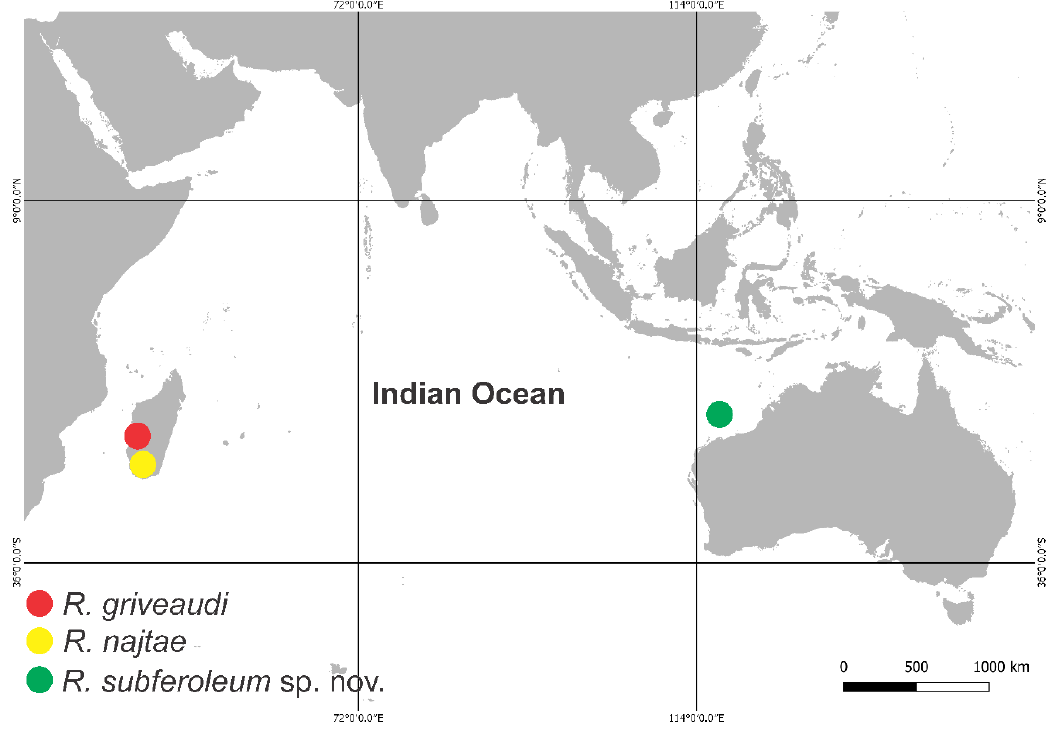
Figure 6. Distribution of Richardsitas species: R. griveaudi (red) and R. najtae (yellow) are known from Madagascar; R. subferoleum sp. nov. is only known from Barrow Island, Western Australia.